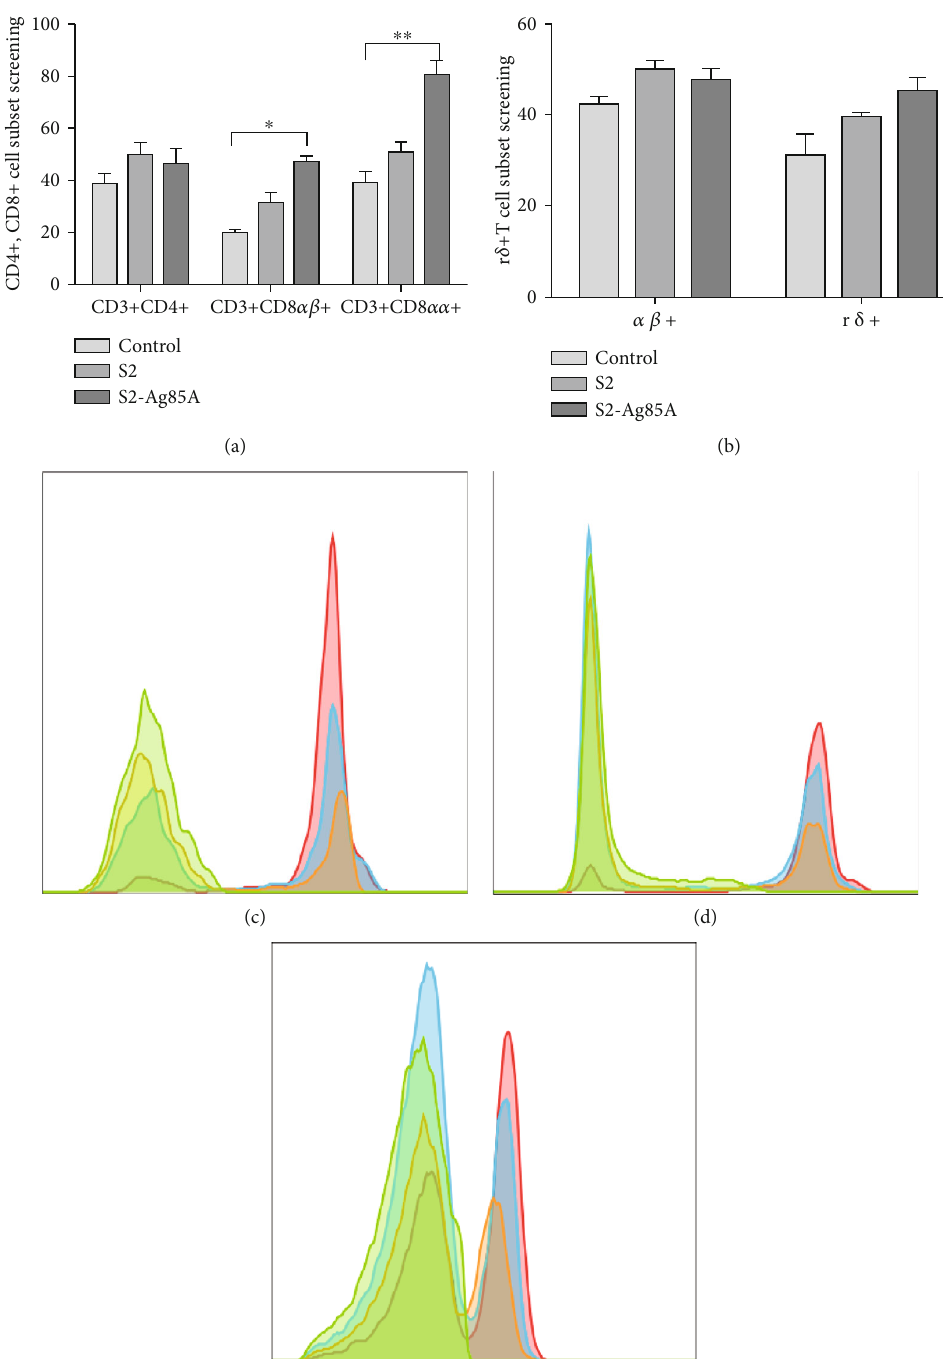
Figure 4: Proliferation of T cell subpopulations in IEL cells promoted by the S2-Ag85A vaccine. (a) CD4+ and CD8+ cell subpopulation screening: CD3+CD8+ αβ and CD3+CD8+ αα cell proliferation was signi fi cantly increased ( P < 0 : 05 ). (b) +T cell subpopulation screening. (c) Flow assay CD8 α +IEL subpopulation results; green, negative unstained; blue, normal control group; red, S2-Ag85A group. (d) Flow detection of CD8 β +IEL subpopulation results; green, negative unstained; blue, normal control group; red, S2-Ag85A group. (e) Flow cytometric detection of TCR+T subpopulation results; green, negative unstained; blue, normal control group; red, S2-Ag85A